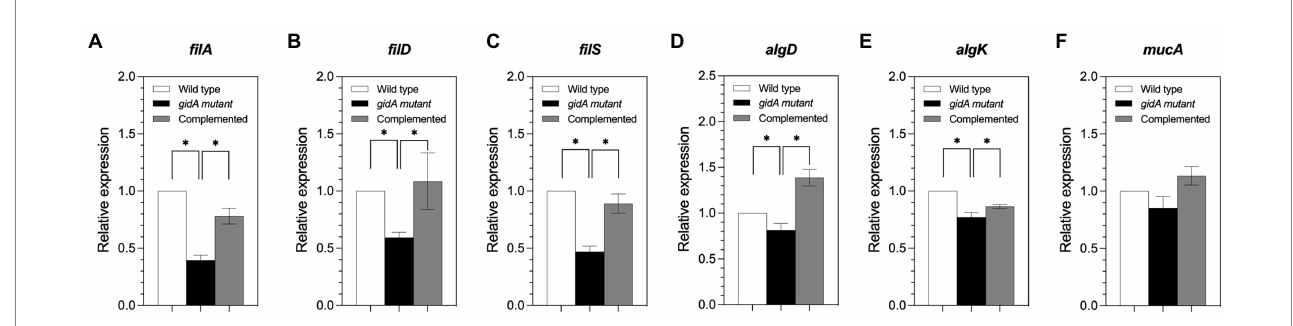
FIGURE 4 The gidA mutant strain shows defects in some motility and biofilm formation gene expression at the mRNA level. (A) Relative mRNA expression levels of fliA , (B) fliD , (C) fliS , (D) algD , (E) algK , and (F) mucA in the wild-type, gidA mutant, and complemented strains. The mRNA expressions of fliA , fliD , fliS (involved in motility), algD , and algK (involved in biofilm formation) genes were reduced in gidA mutant strains. The data represent the mean ± SD values of three biological replicates. The statistical analysis was performed using Graphpad Prism (GraphPad Software). Asterisks denote a significant difference in the one- way ANOVA (* p ≤ 0.05).